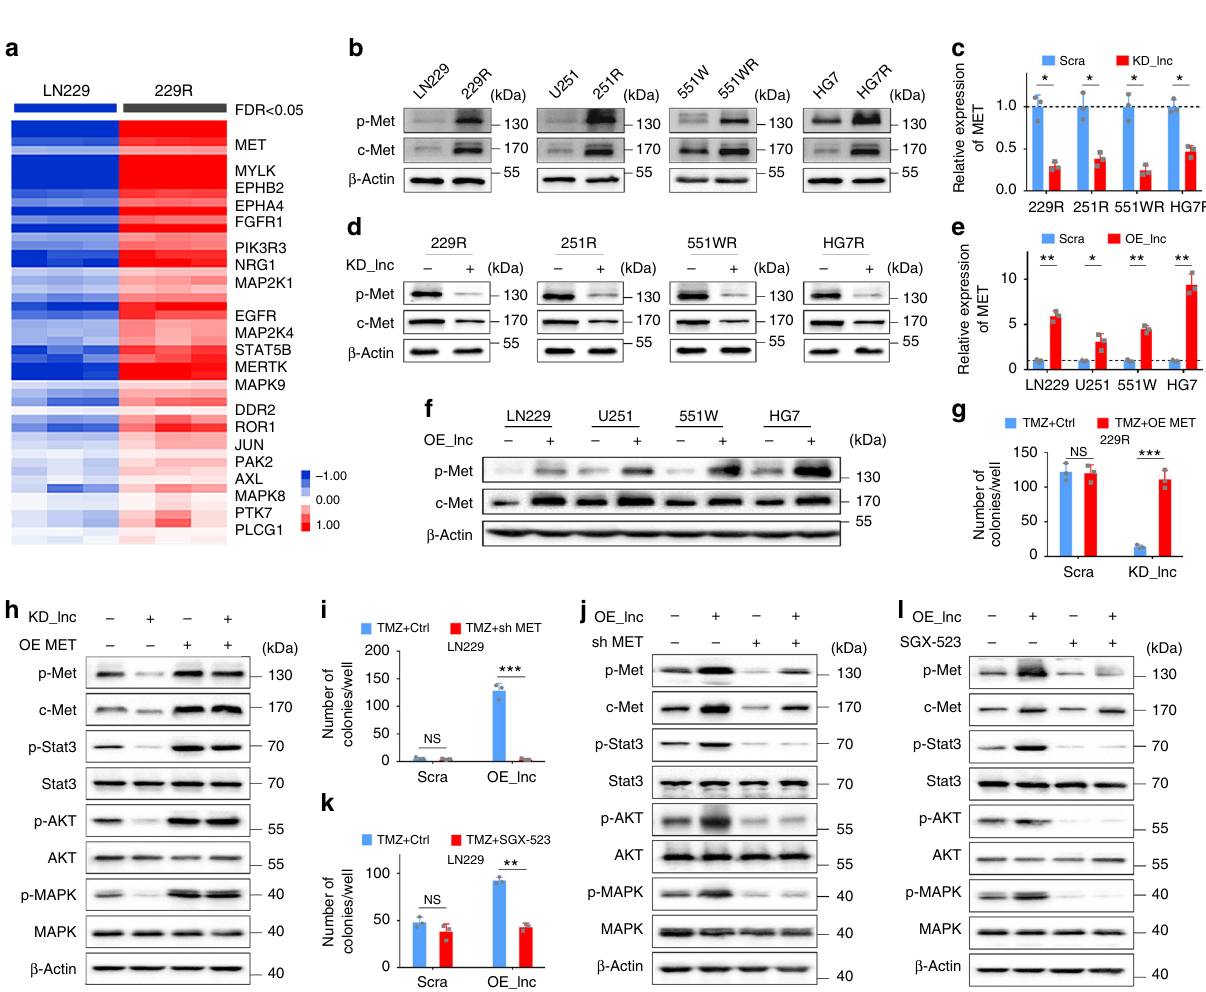
Fig. 4 Met regulated by lnc-TALC is highly expressed in recurrent GBM and is required for TMZ resistance. a The levels of RTK molecules were analyzed in mRNA microarray pro fi les. b Western blot analysis of p-Met and c-Met levels in TMZ-resistant and parental GBM cells. c qRT-PCR analysis of the effect of lnc-TALC knockdown on MET expression in TMZ-resistant GBM cells. d Western blot analysis of c-Met and p-Met levels affected by lnc-TALC knockdown in TMZ-resistant GBM cells. e qRT-PCR analysis of the effect of lnc-TALC overexpression on MET expression in parental GBM cells. f Western blot analysis of c-Met and p-Met levels affected by lnc-TALC overexpression in parental GBM cells. g Colony formation assay of the effect of MET overexpression on 229R knock down of lnc-TALC with TMZ treatment (100 μ M) in a six-well dish (300 cells per well) for 11 days ( n = 3). The average number of colonies is shown. h Western blot analysis of the indicated proteins in 229R GBM cells after lnc-TALC knockdown or MET overexpression. i Colony formation assay of the effect of sh-MET on LN229 overexpressing lnc-TALC with TMZ treatment (100 μ M) in a 6-well dish (300 cells per well) for 11 days ( n = 3). The average number of colonies is shown. j Western blot analysis of the indicated proteins in LN229 GBM cells after lnc-TALC overexpression or MET knockdown. k Colony formation assay of the effect of SGX-523(200nM) on LN229 cells overexpressing lnc-TALC with TMZ treatment (100 μ M) in a six-well dish (300 cells per well) for 11 days ( n = 3). The average number of colonies is shown. l Western blot analysis of the indicated proteins in LN229 GBM cells after SGX-523 (200 nM) treatment. Data are presented as the mean ± S.D. P value was determined by Student ’ s t - test. Signi fi cant results were presented as NS non-signi fi cant, * P < 0.05, ** P < 0.01, or *** P <